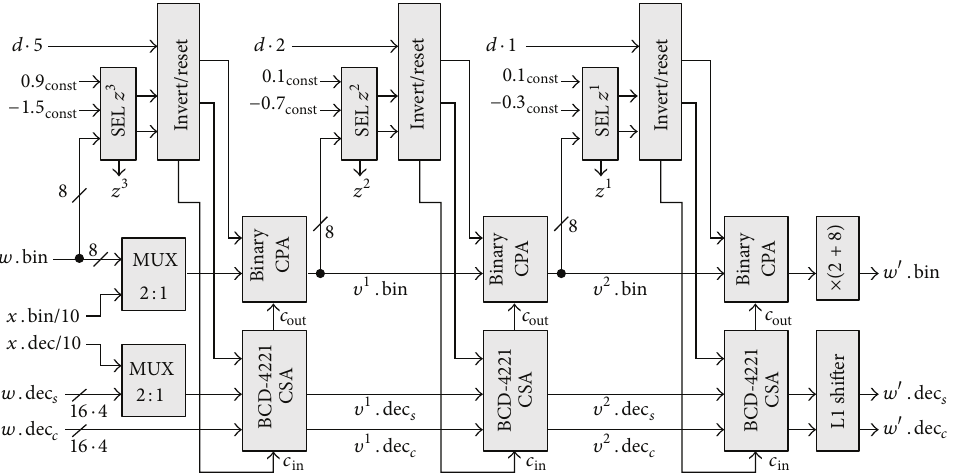
Figure 7: Block diagram of type4 digit recurrence.